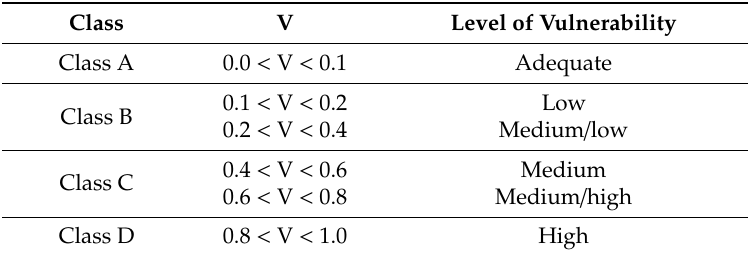
Table 5. Ranges of the vulnerability index provided by GNDT method